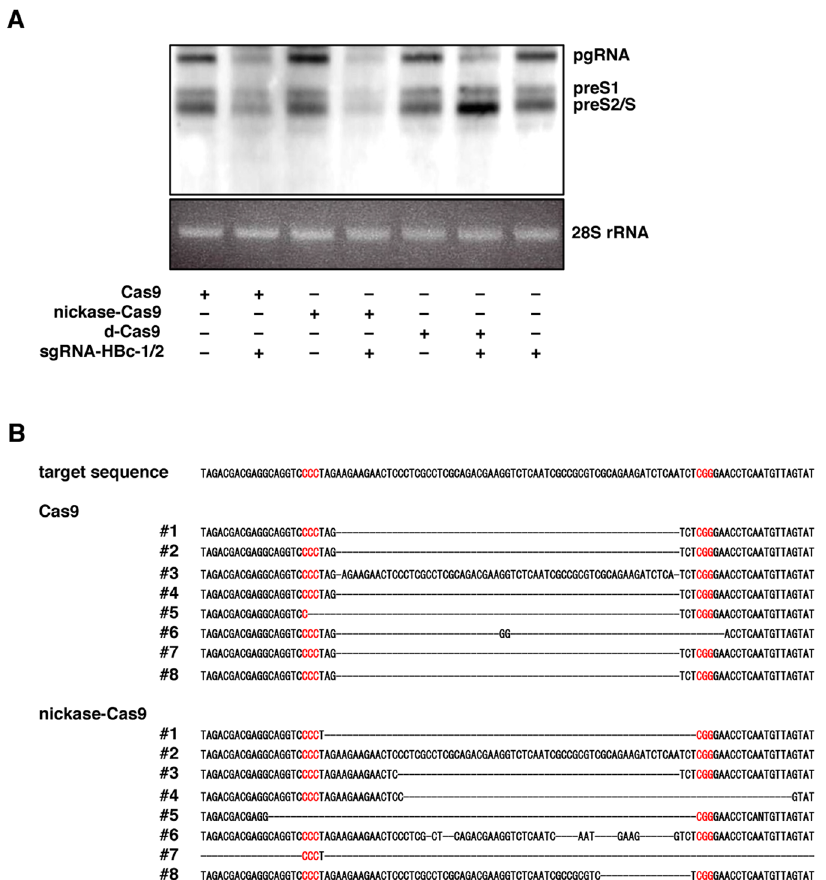
Figure 5. Characterization of the Cas9-mediated suppression of HBV replication. ( A ) HepG2.2.15.7 cells transduced with Cas9, nickase-Cas9 and d-Cas9 together with the pair of sgRNAs were collected at 5 days post- transduction, and the intracellular HBV RNA were determined by Northern blotting. ( B ) Total DNAs were extracted from HepG2.2.15.7 cells transduced with Cas9 and nickase-Cas9 together with the sgRNAs at 5 days post-transduction, and the target HBV sequences were directly sequenced after amplification. * p < 0.01 vs. the results for control cells. (full-length gels are presented in Supplementary